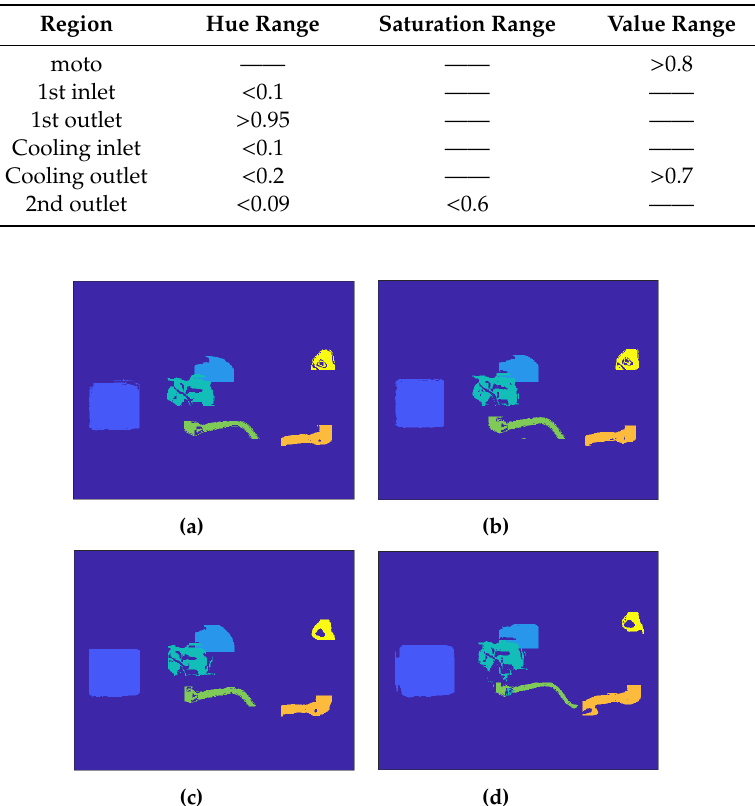
Figure 5. Screening results of points with similar heating rates in six regions under 4 different working conditions: ( a ) BL, ( b ) AFB, ( c ) ASW, ( d ) DVL. Sensors 2020 , 20 , x FOR PEER REVIEW